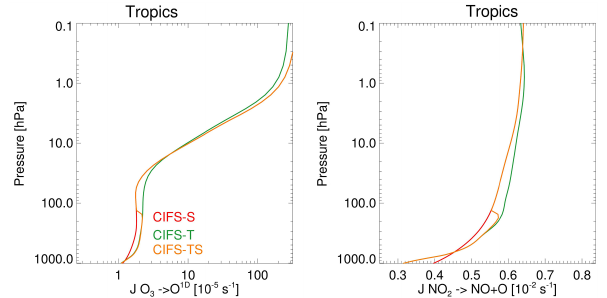
Figure 1. Illustration of the merging procedure for photolysis rates between the tropospheric and stratospheric parameterizations for the reactions O 3 → O 1 D (left) and NO 2 → NO + O (right) as zon- ally averaged over the tropics for 1 April